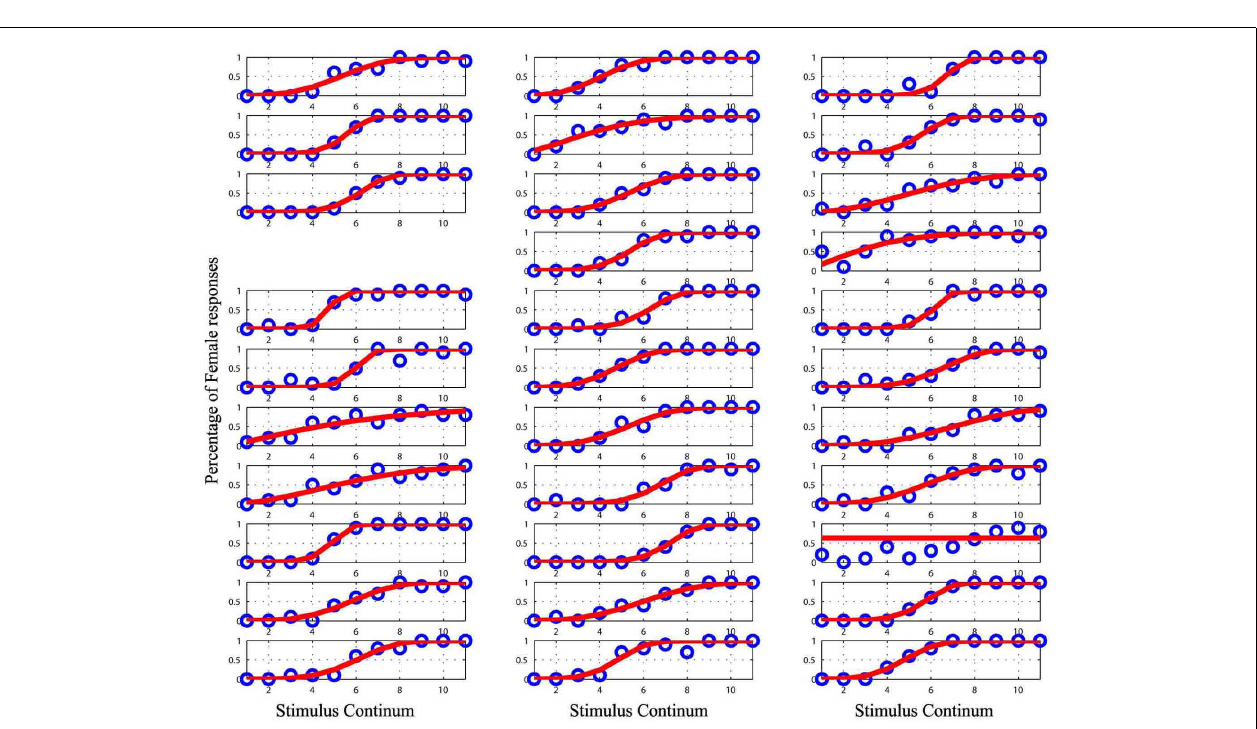
FIGURE 3 | Plot of the raw data (blue circles) and the cumulativeWeibull function (red lines) for each subject in the original male/female